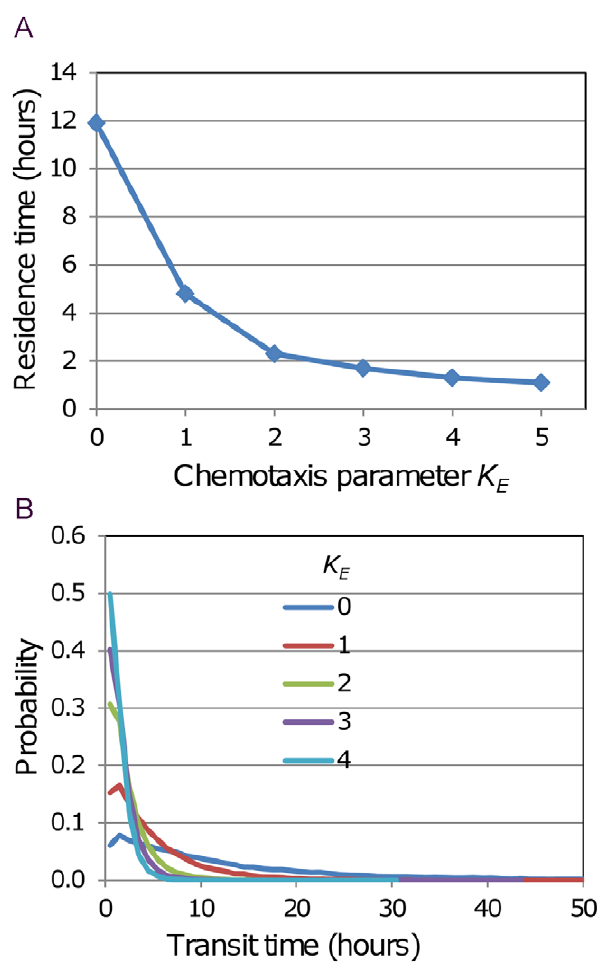
Figure 8. Dependence of transit time distribution on K E for cells subject to chemotaxis. In steady-state simulations with 50 k cells and with the number of exit portals and influx rate corresponding to T res =12 h, 10% of the cells entering in the first 48 hours were tagged and made susceptible to chemotaxis, with values of K E ranging from 1.0 to 5.0. The tagged cells were tracked and their transit times determined. Results from the five simulations with K E . 0 are compared with the no- chemotaxis case. (A) Dependence of residence time (mean transit time) on K E . (B) Transit time probability distributions (the distribution for K E =5 is very close to that for K E =4 and has been omitted for clarity).